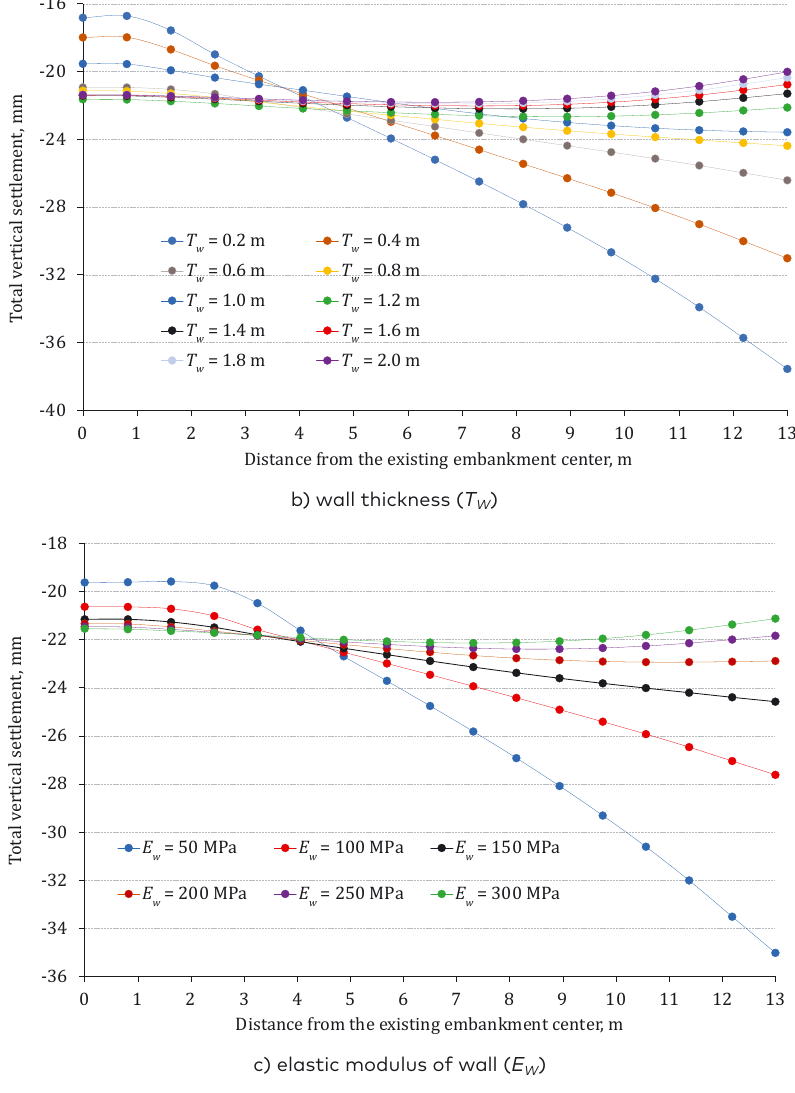
Figure 8. Effect of the depth ( D W ), thickness ( T W ) and elastic modulus ( E W